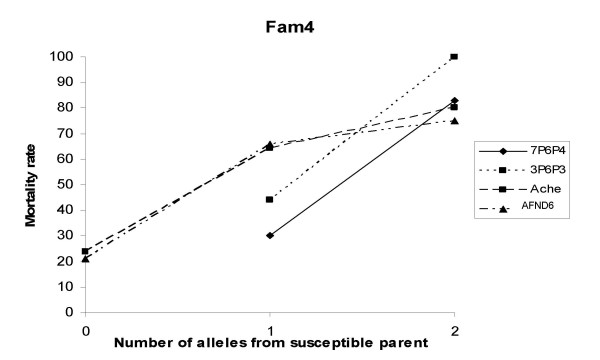
Plot of mortality rate as a function of alleles inherited from the susceptible parent in family 4 for significant markers on chromosome 2.